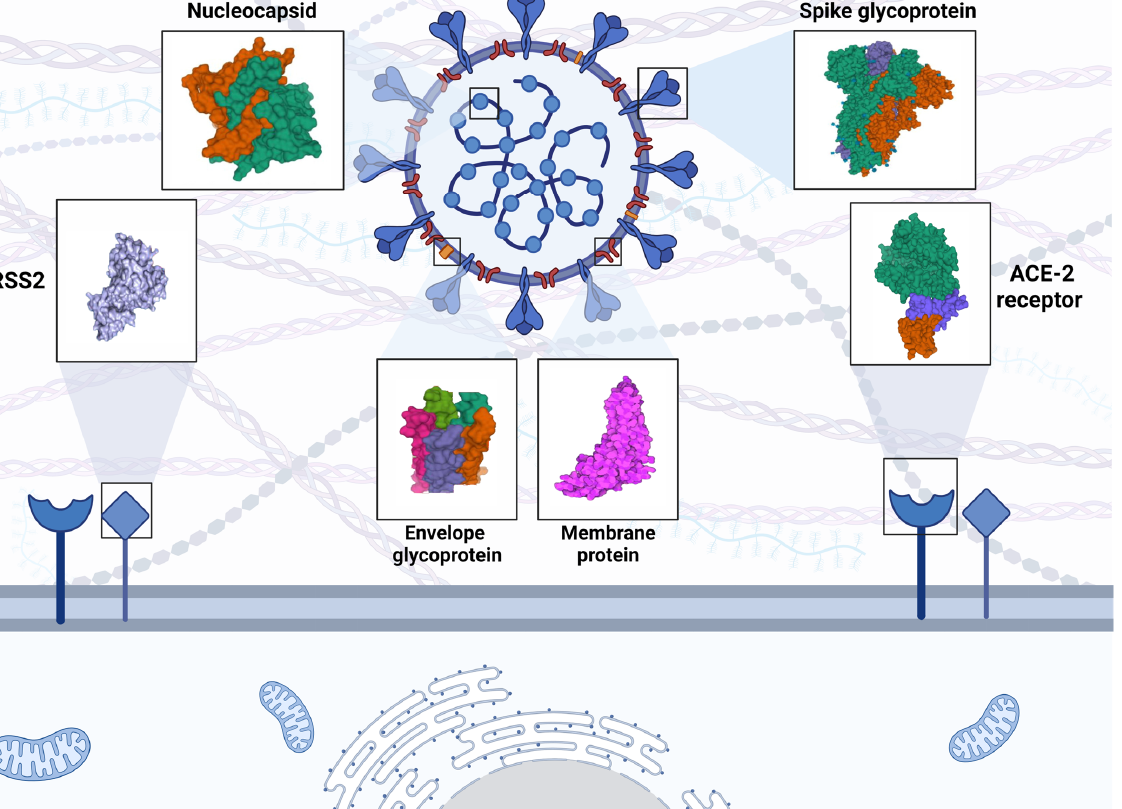
Figure 1. SARS-CoV-2 characteristics. The proteins S glycoprotein, E glycoprotein, M, and N